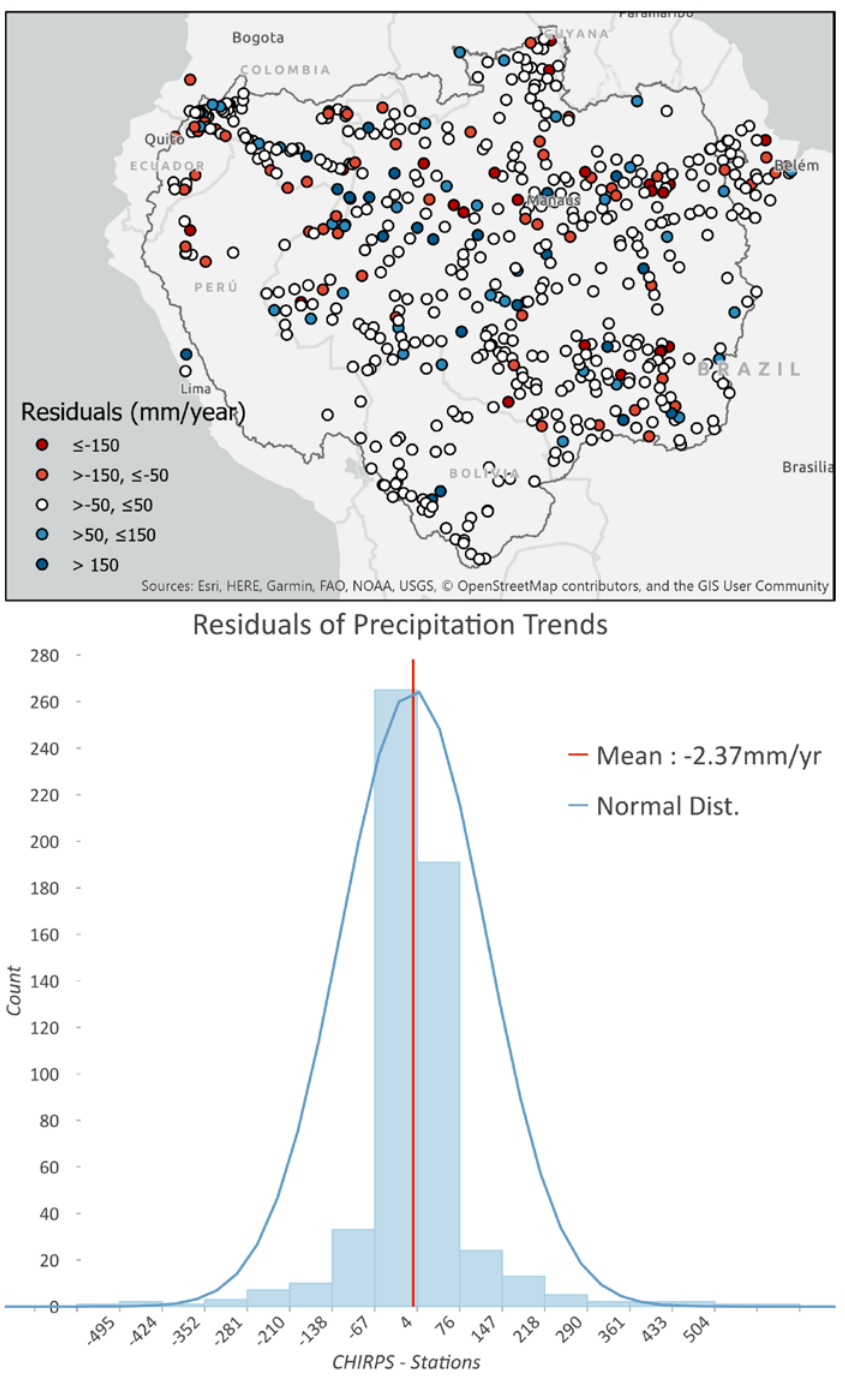
Figure 6. Residuals of the difference between precipitation trends estimated using CHIRPS and station data (mm/year) from 1981 to 2017 ( top ) and its histogram ( bottom ) centered at a mean value of − 2.37 mm/year.